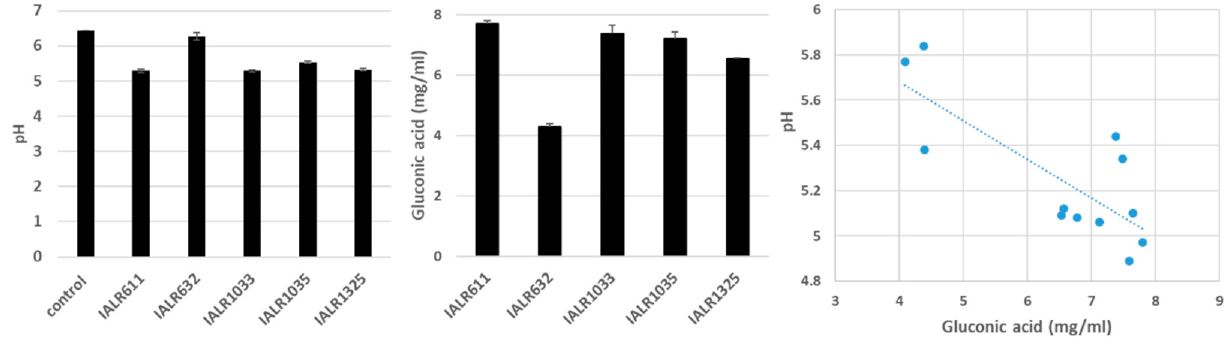
Figure 2. pH changes and gluconic acid production by bacteria after 4 days of culture.